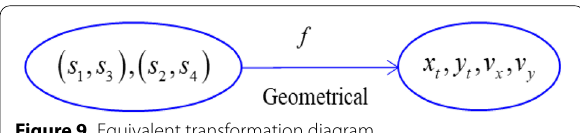
Figure 9 Equivalent transformation